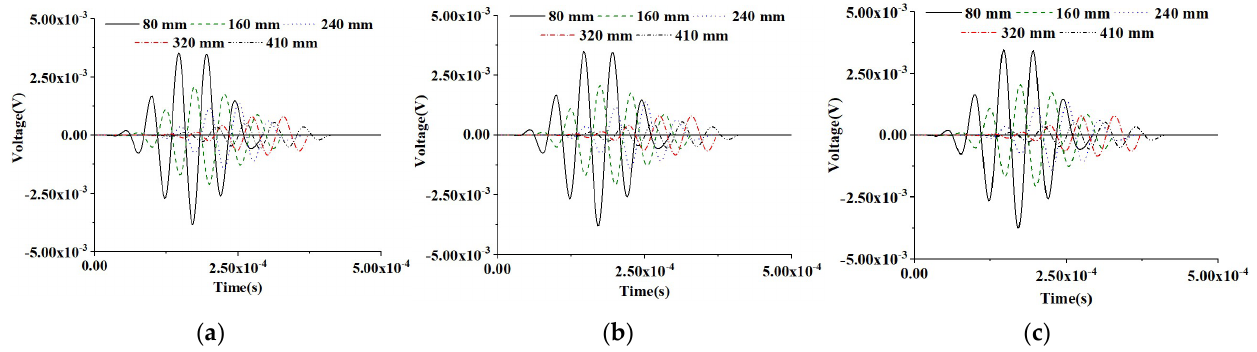
Figure 13. Response of sensors at different measurement distances from the actuator under a modulated excitation signal for CHFEMs with an interface debond defect using different RAE dimensions: ( a ) 20 mm; ( b ) 25 mm; ( c ) 40 mm.